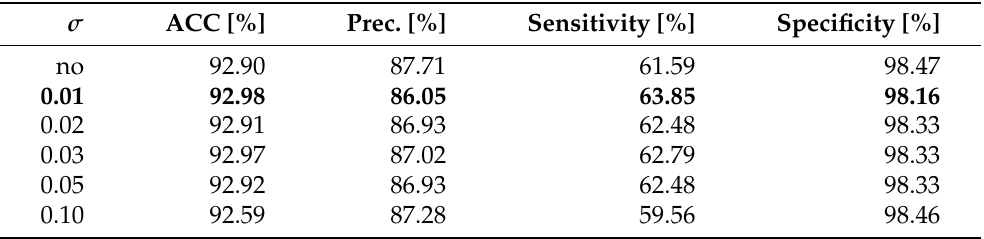
Table 6. Results of the linking model on the validation set, depending on the variance of Gaussian noise. From each data sequence, 5 new sequences were created by adding noise with variable standard deviation σ . The data comes from the best eras. They were obtained by the fivefold cross-validation method.